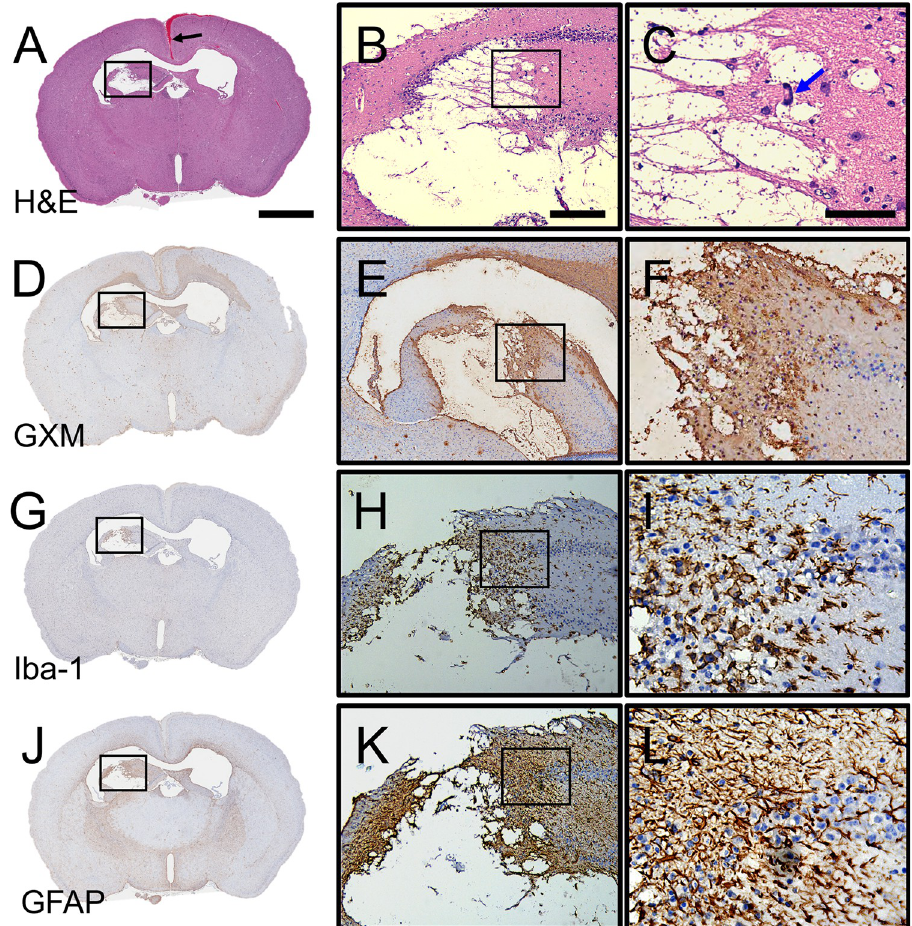
Fig 5. Cerebral cryptococcosis in mice infected in the ventricles. Representative coronal brain sections (scale bar: 1 mm) of ventricle-infected mice stained with (A-C) H&E, (D-F) GXM-specific mAb 18B7, (G-I) Iba-1 (microglia), and (J-L) GFAP (astrocytes) are shown. Mouse brains were excised 7-dpi. Middle (scale bar: 100 μ m) and right (scale bar: 20 μ m) panel images are a magnification of the smaller box in the corresponding left-stained section to better show the tissue morphology, GXM distribution (brown stain), and glial cell recruitment/activation (brown stain). Black arrow in A denotes subarachnoid space hemorrhage. Blue arrow in C indicates the presence of megakaryocytes and indicative of thrombosis. Five mice per infection route were evaluated to confirm all the histopathological observations reported in these studies.